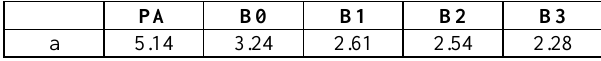
Table 3. Estimation of a (assessed April 5, 2012).